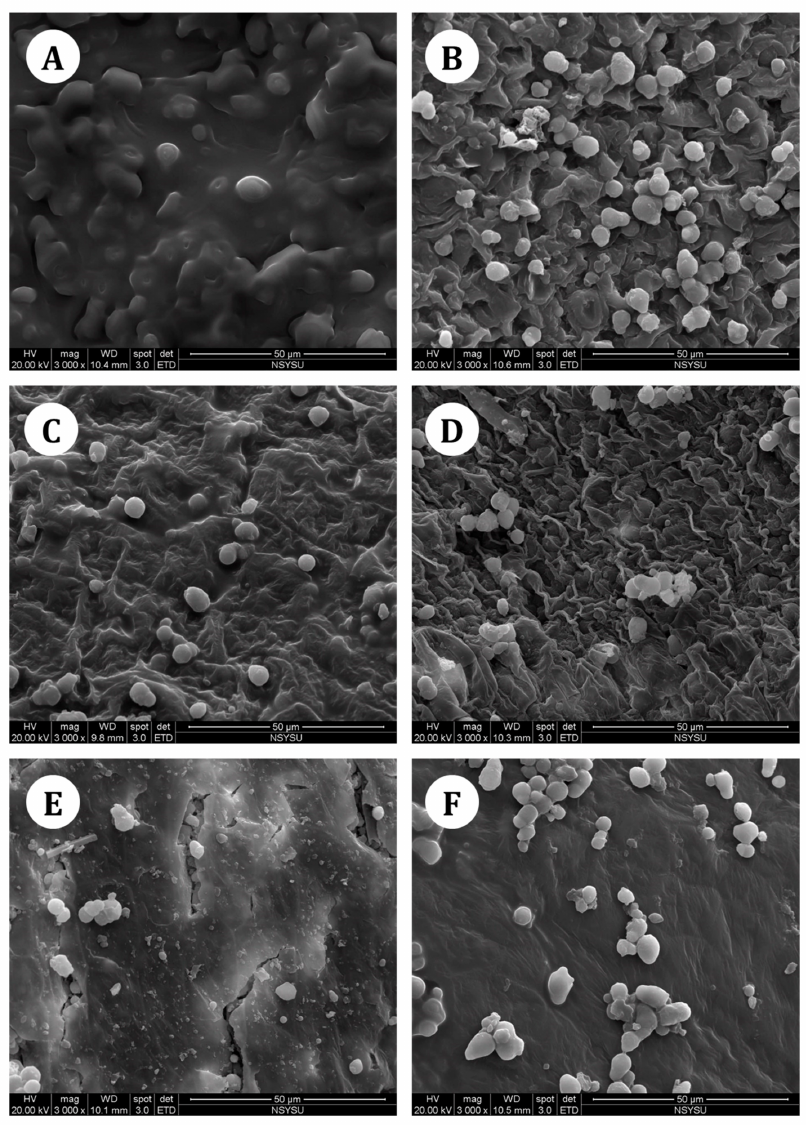
Figure 5. Scanning electron microscopy images of ( A ) crude hemp nut and hemp nut after ( B ) MAE, ( C ) HRE, ( D ) SE, ( E ) SFE, and ( F )